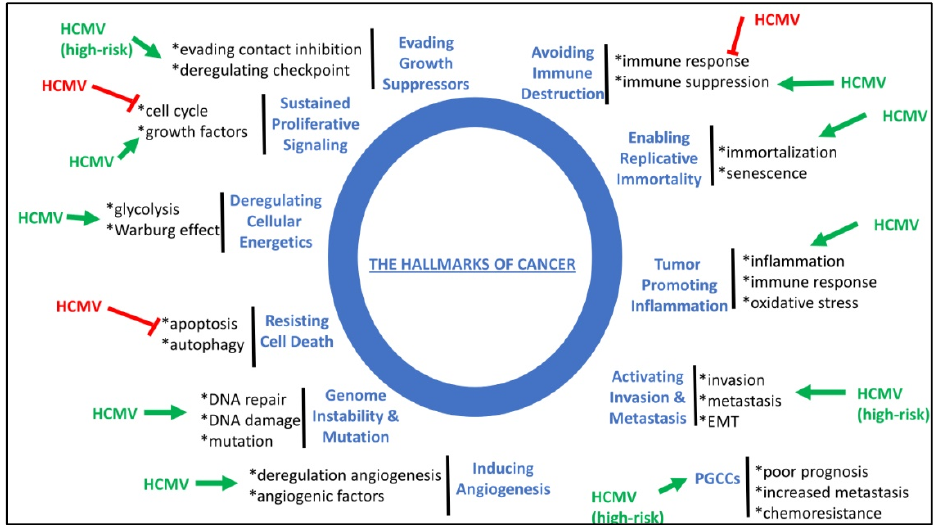
Figure 3. HCMV fulfills all the hallmarks of cancer and thereby could modulate the initiation and development of tumors. HCMV stimulates (green arrow) or blocks (red block) the molecular mechanisms involved in the hallmarks of cancer. The formation of PGCCs could be added as a new hallmark of cancer. High-risk HCMV strains might impact specifically some of the hallmarks of cancer where specified. cancer where